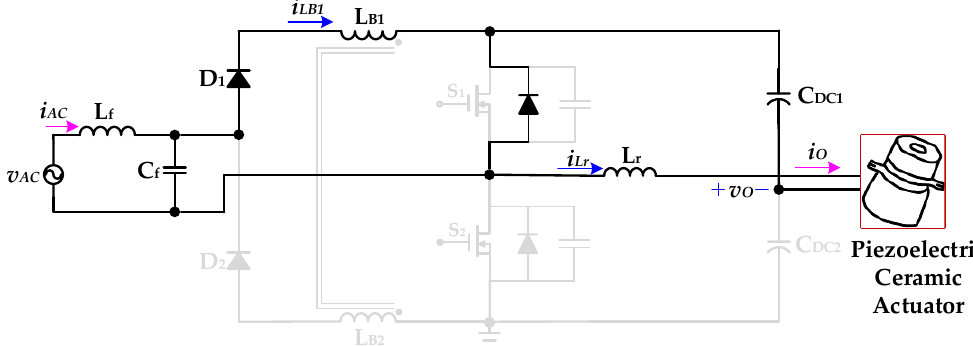
Figure 11. Operation Mode 6 of the proposed drive circuit for the piezoelectric ceramic actuator.